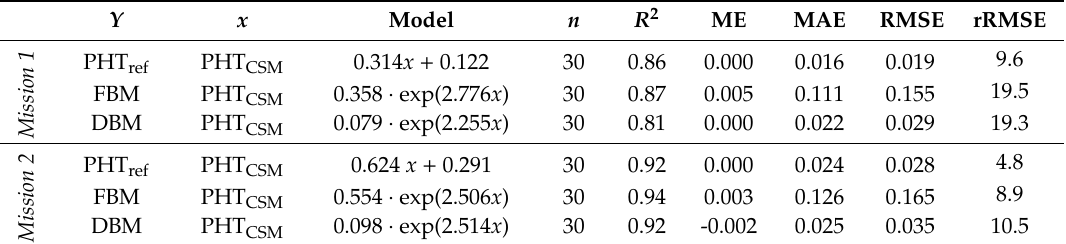
Table 3. Regression models obtained between plant height and biomass for di ff erent missions and its residuals. x = dependent variable; y = independent variable; ME = mean error; MAE = mean